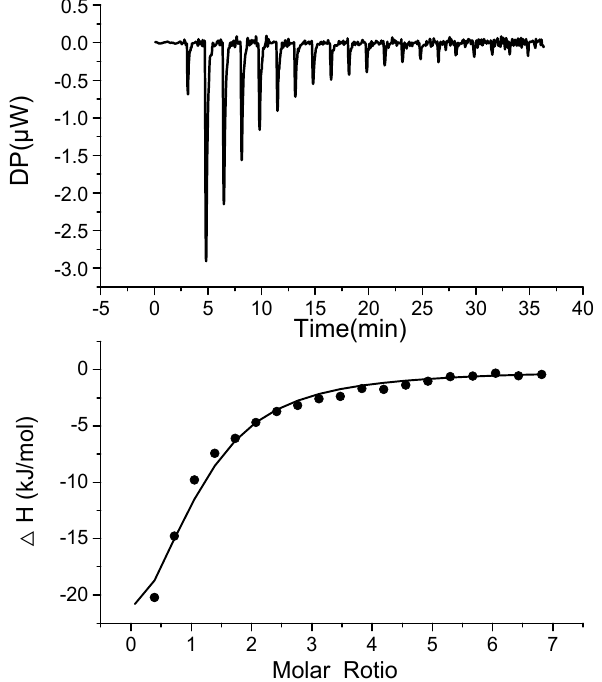
Figure 1. ITC measurement ( top panel) and binding isotherm fitted by one set of the site’s model ( bottom panel) for the titration of BPA to aptamer BP60.